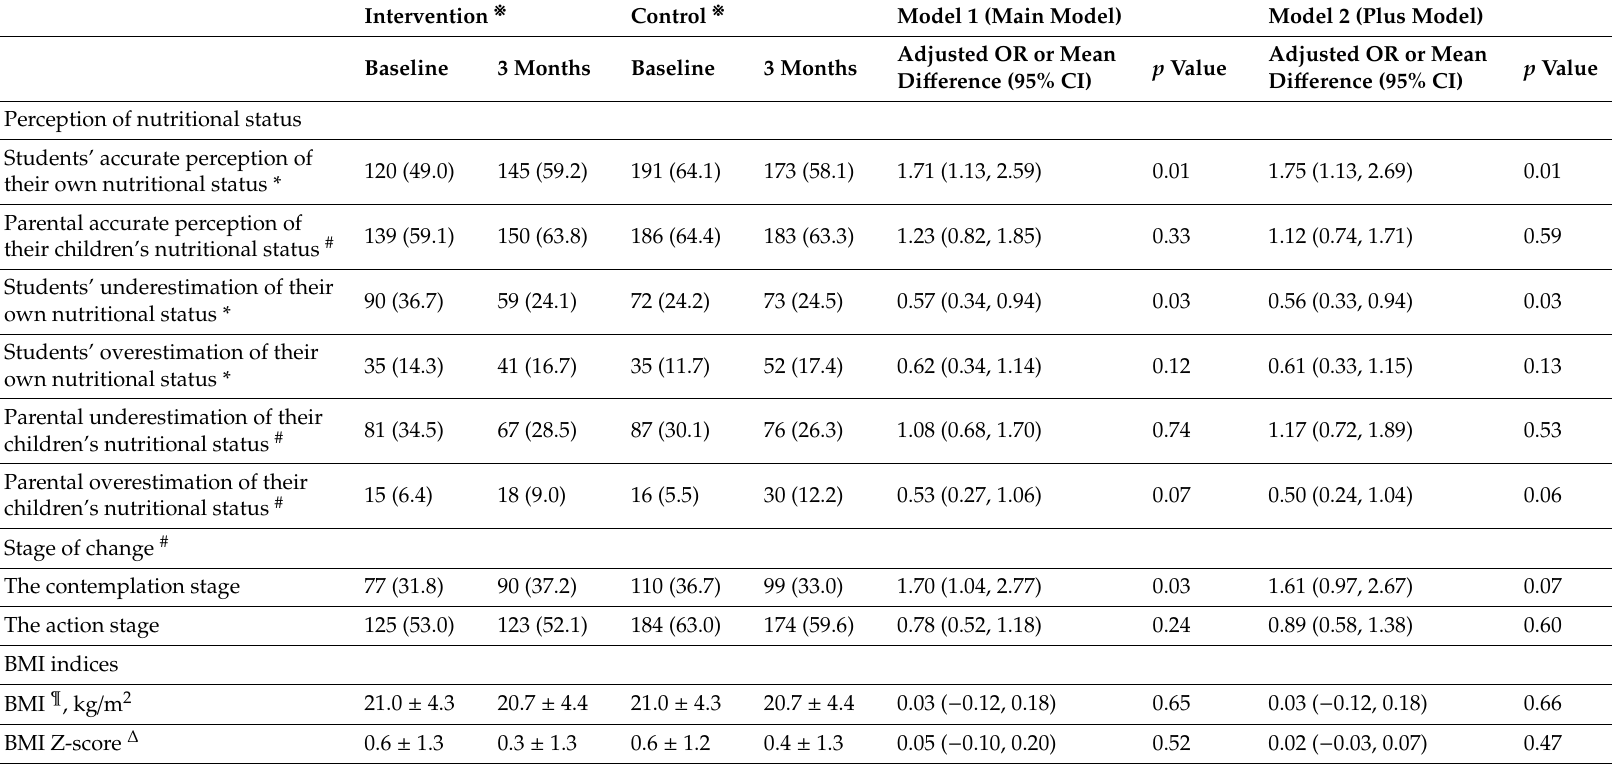
Table 2. Intervention e ff ect at 3